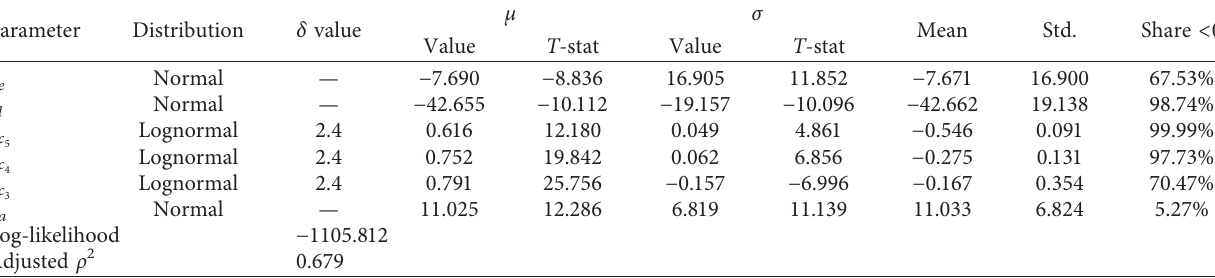
Table 12: The estimates of mixed logit departure time choice